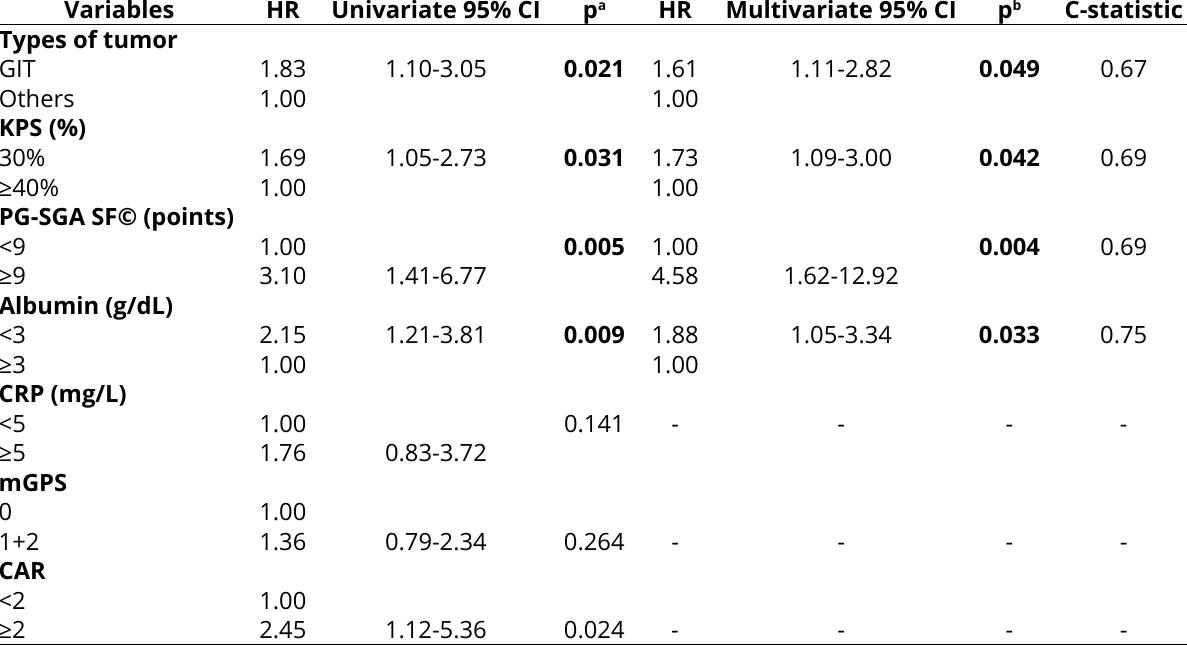
Figure 1. Survival curves of inpatients with advanced cancer according to selected variables (n=136). Abbreviations: n = Number of observations; KPS = Karnofsky Performance Status; PG-SGA SF© = Patient-Generated Subjective Global Assessment short form; CAR = C-reactive protein albumin Table 2. Prognostic factors within 30-day among inpatients with advanced cancer (n=136).